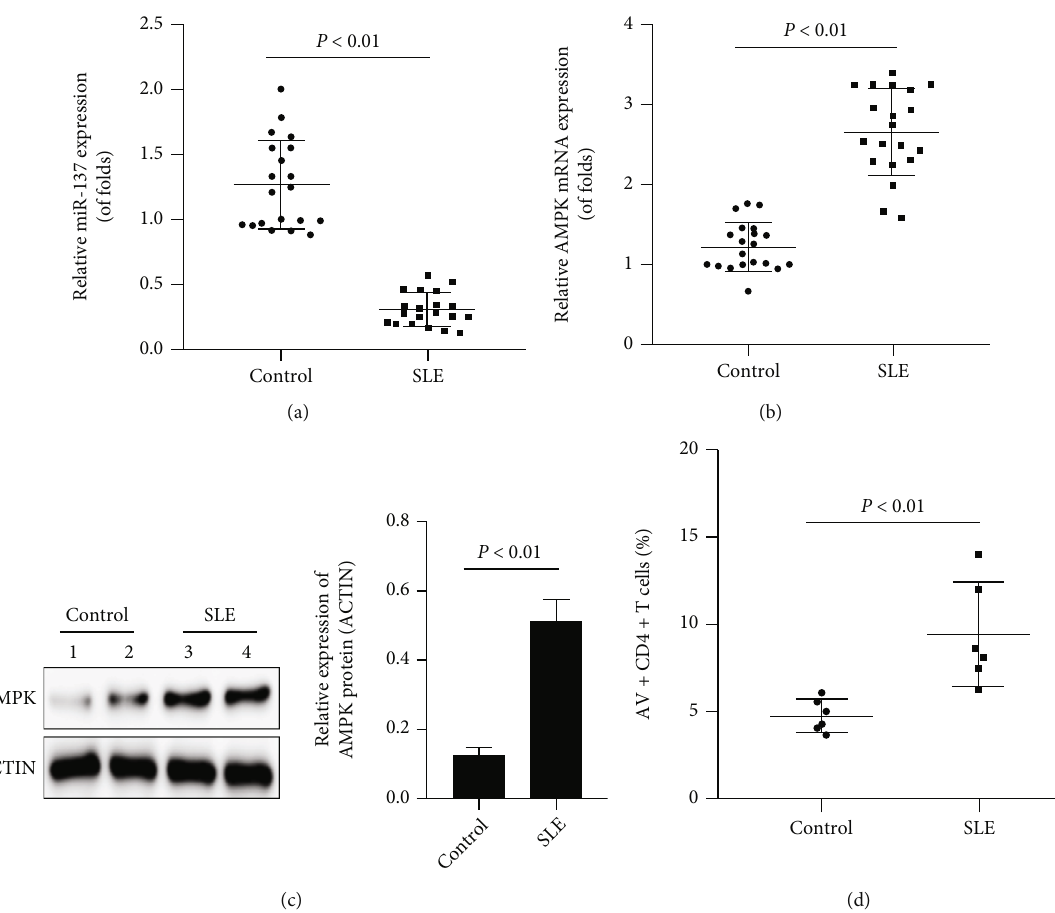
Figure 1: miR-137 and AMPK expressions in isolated CD4+ T cells. (a) miR-137 in isolated CD4+ T cells; (b) AMPK mRNA in isolated CD4+ T cells; (c) AMPK protein in isolated CD4+ T cells; (d) apoptosis level by fl ow cytometry. Each test ran in triplicates. The means were pairwisely compared using Student ’ s t -test. P < 0 : 01 means the presence of statistical signi fi